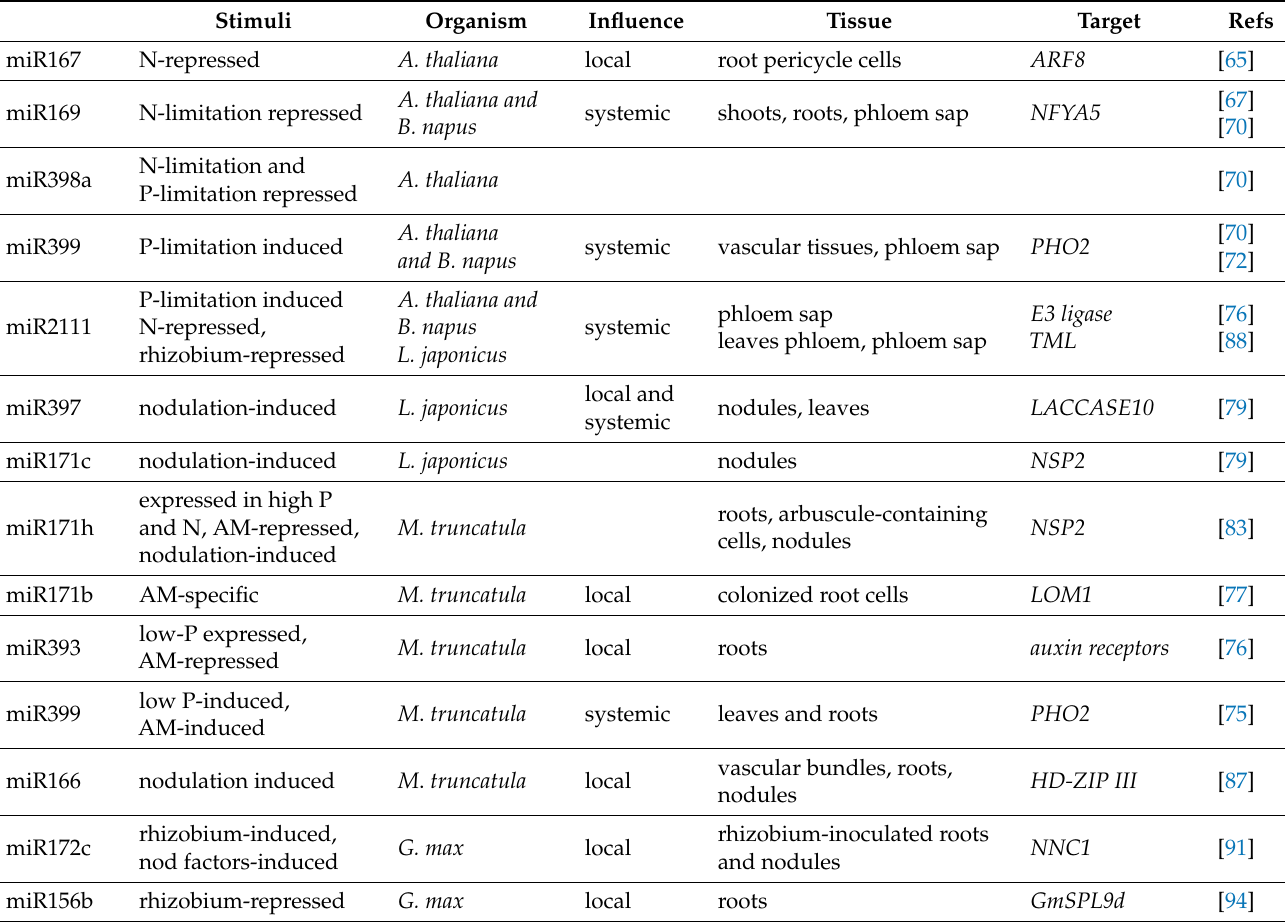
Table 2. List of selected miRNAs responding to nitrogen (N), phosphorus (P) and microsymbionts (rhizobium and AM